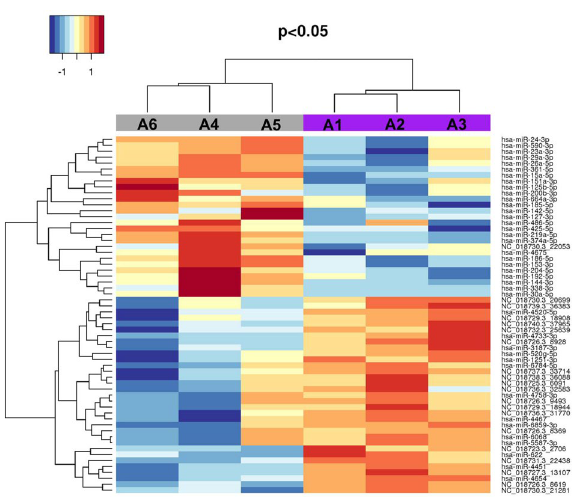
Figure 5. Heatmap created using the R package "gplots", version 3.03 (https:// rstud io. com/ produ cts/ rpack ages/) with the 60 significant miRNAs (nominal P-val < 0.05). The grey bar and the purple bar represent the healthy (A4, A5, and A6) and the affected (A1, A2, A3) Abyssinians, respectively. The shades of blue refer to down-regulated miRNAs while the shades of red refer to up-regulated